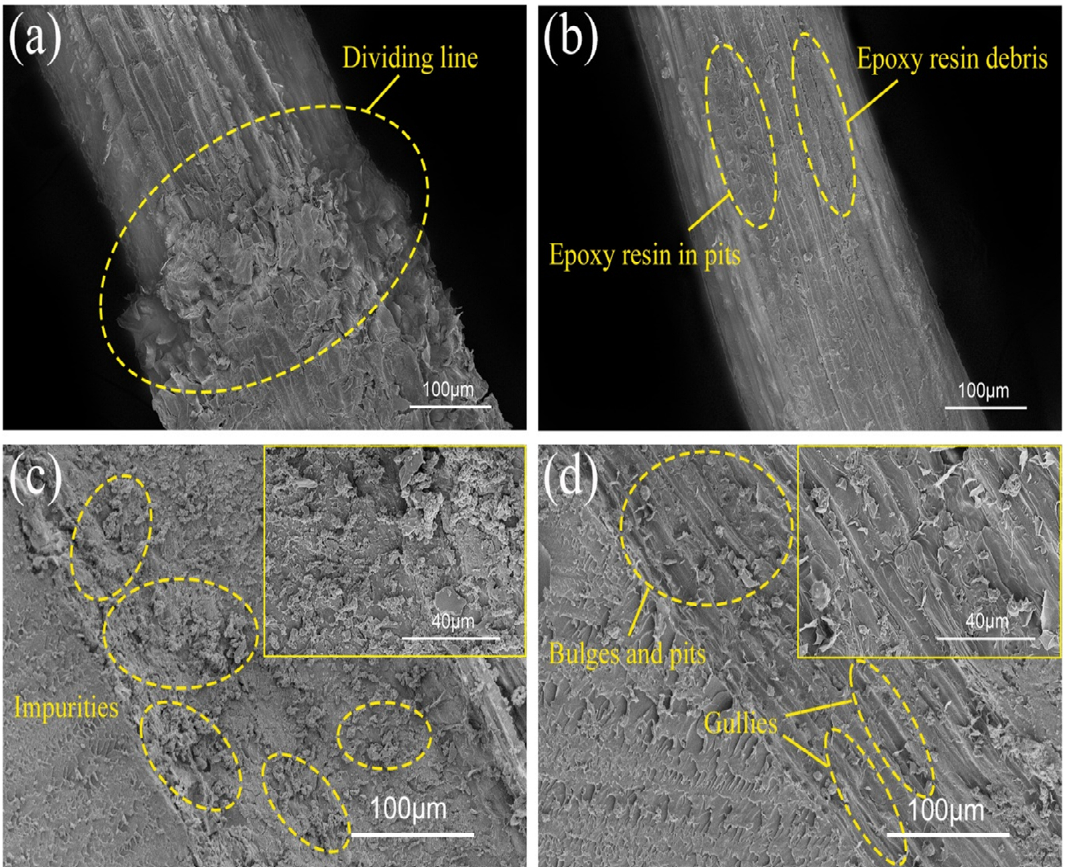
Figure 9. SEM micrographs of interfaces after completing the single-fiber pullout test: ( a ) U-CF, ( b ) A-S-CF, ( c ) matrix of U-CFPS, and ( d ) matrix of A-S-CFPS.